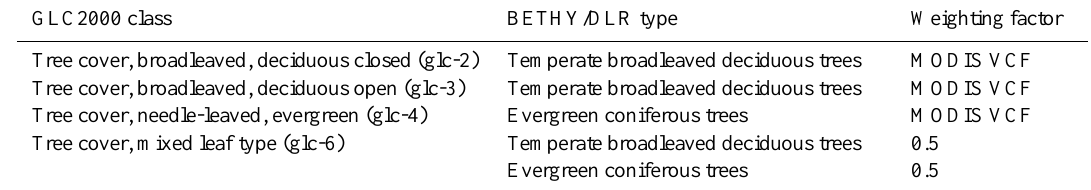
Table 1. Translation of GLC2000 vegetation classes to BETHY/DLR vegetation types with weighting factors. GLC2000 class